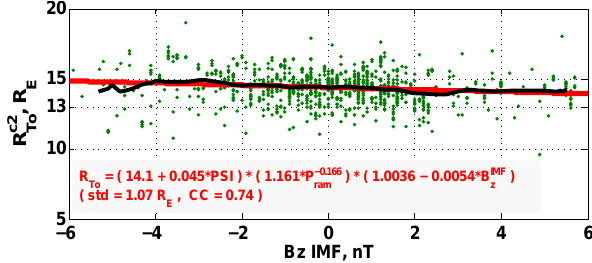
Figure A3. Relationship between IMF B z and terminator radius corrected to eliminate the dipole tilt and ram pressure dependences. Red straight line – regression line. Black line is the moving average (with the window size 2nT, step size 0.2nT).